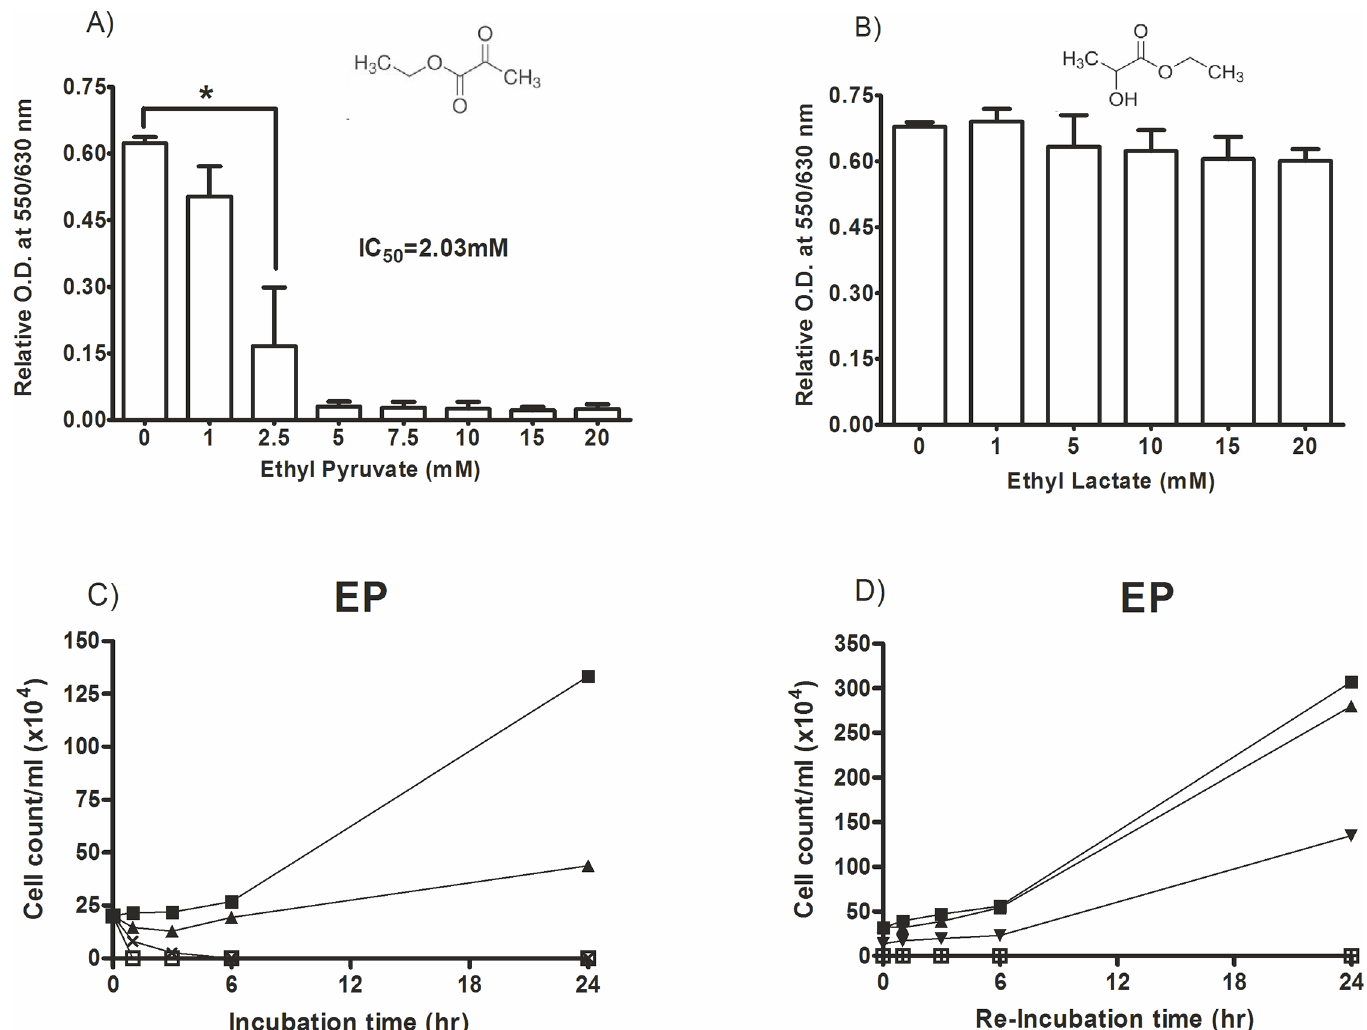
Fig 1. Effect of ethyl pyruvate and ethyl lactate on T. brucei cells proliferation. A cell proliferation/viability assay was conducted in 96-well cell culture plates containing 2x104 cells, medium and ethyl pyruvate in a volume of 200 μ l. After 24 hrs of incubation the AlamarBlue cell proliferation reagent (20 μ l) was added and the absorbance was read: (A) Ethyl pyruvate; (B) Ethyl lactate; (C) For the time-dependency test 2x105 cells/ml were cultured in 24-well plates in the presence of different concentrations of ethyl pyruvate at 0 mM ( ■ ), 1 mM ( ▲ ), 2.5 mM (x) and 5 mM ( □ ). After certain time intervals aliquots were removed and the number of vital cells was counted. (D) For cell-recovery test 2x105 cells/ml were cultured in the presence of ethyl pyruvate at 0 mM ( ■ ), 1 mM ( ▲ ), 2.5 mM ( ▼ ), 5 mM ( □ ) for 3 hrs in 24-well plates. Then, the medium was removed and the cells were replenished with fresh medium without the ethyl pyruvate and further cultured for 24 hrs. At the indicated time points aliquots were removed and vital cells were counted. Cells were cultured at 37°C containing 5% CO2 in a 100% humidified environment, * p < 0.05.